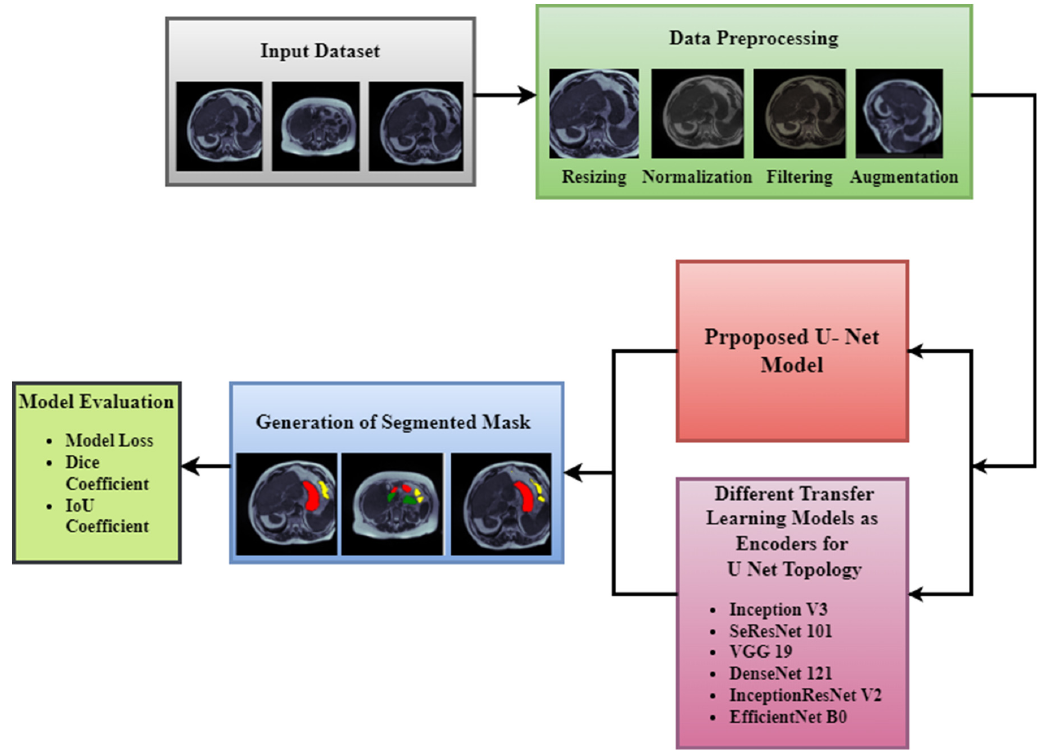
Figure 1. Proposed Methodology for GI Tract Segmentation .